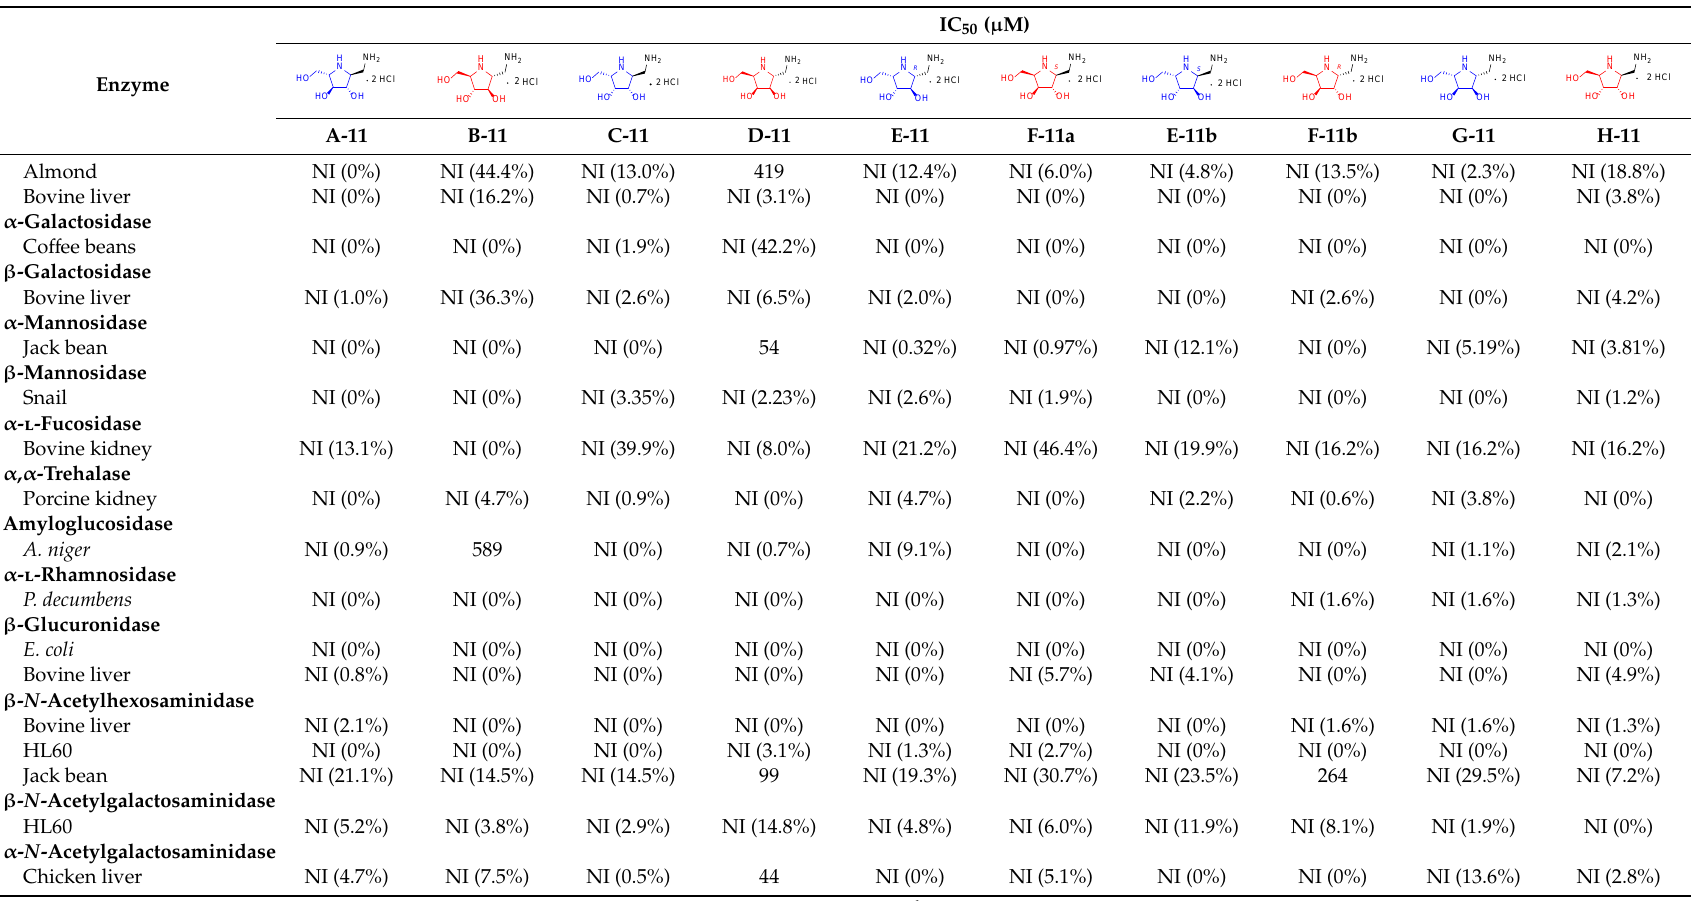
Table 3. Concentrations of 1-amino pyrrolidine analogues giving 50% inhibition of various enzymes.